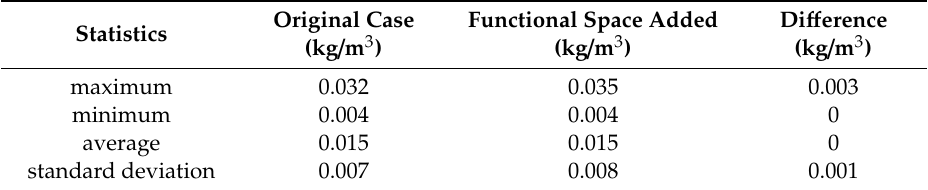
Table 5. Statistics of absolute humidity in the tomb